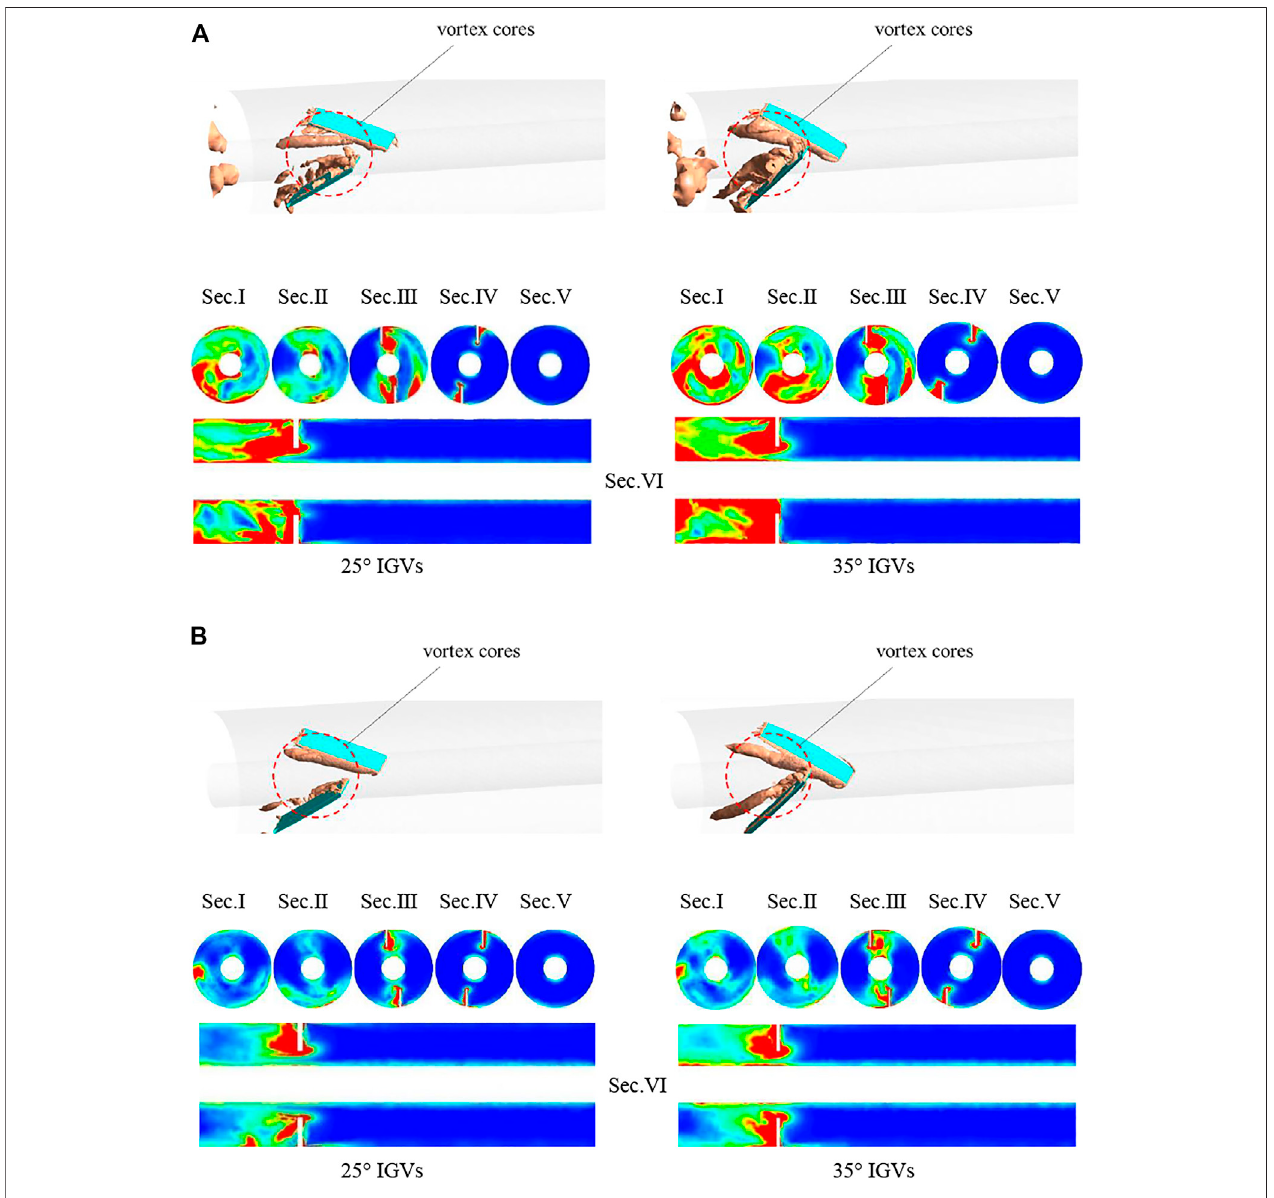
FIGURE 12 | Contours of the entropy generation rate at different cross-sections and vortex cores of the inlet pipe: (A) 0.6 Q d and (B) 0.8 Q d .